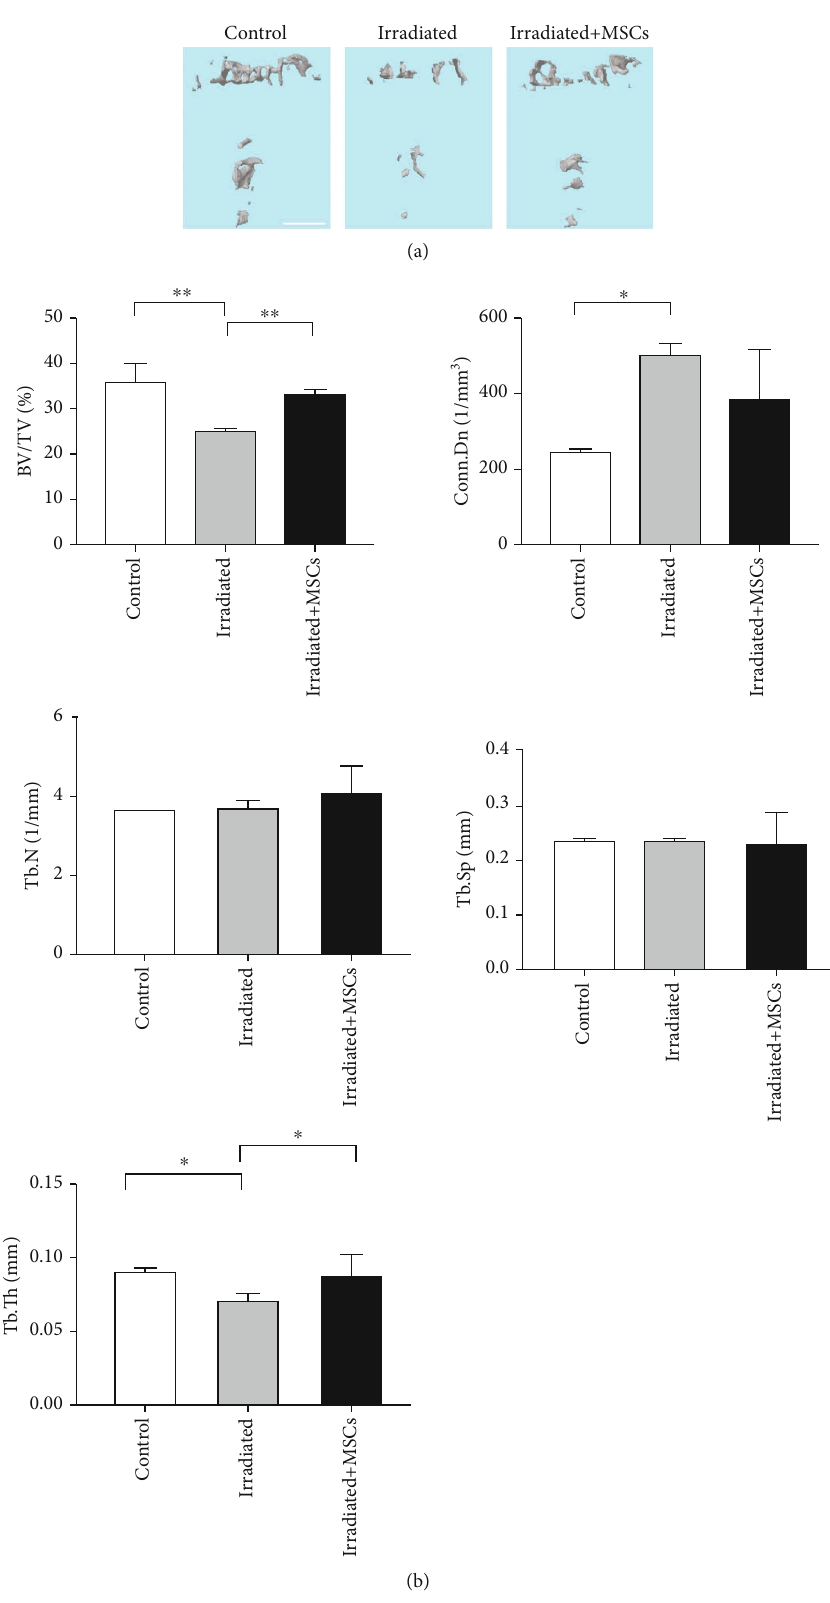
Figure 4: hUCB-MSC treatment can rescue the e ff ect of irradiation on bone mass in mice. (a) Representative μ CT images (scale bars, 0.5mm). (b) Statistics of cortical bone parameters by μ CT from mice implanted with control, MSC treatment, and irradiated ( n = 5 ). Tb.Sp; Tb.N; Tb.Th; BV/TV; Conn.Dn. All data are mean ± SD ; ∗ P < 0 : 05 ; ∗∗ P < 0 : 01